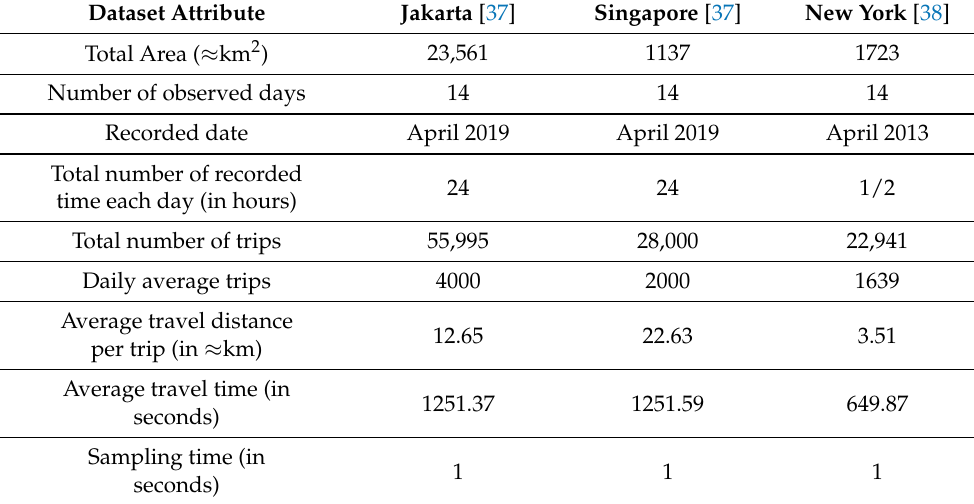
Table 1. Empirical Mobility Traces Attributes and Simulation